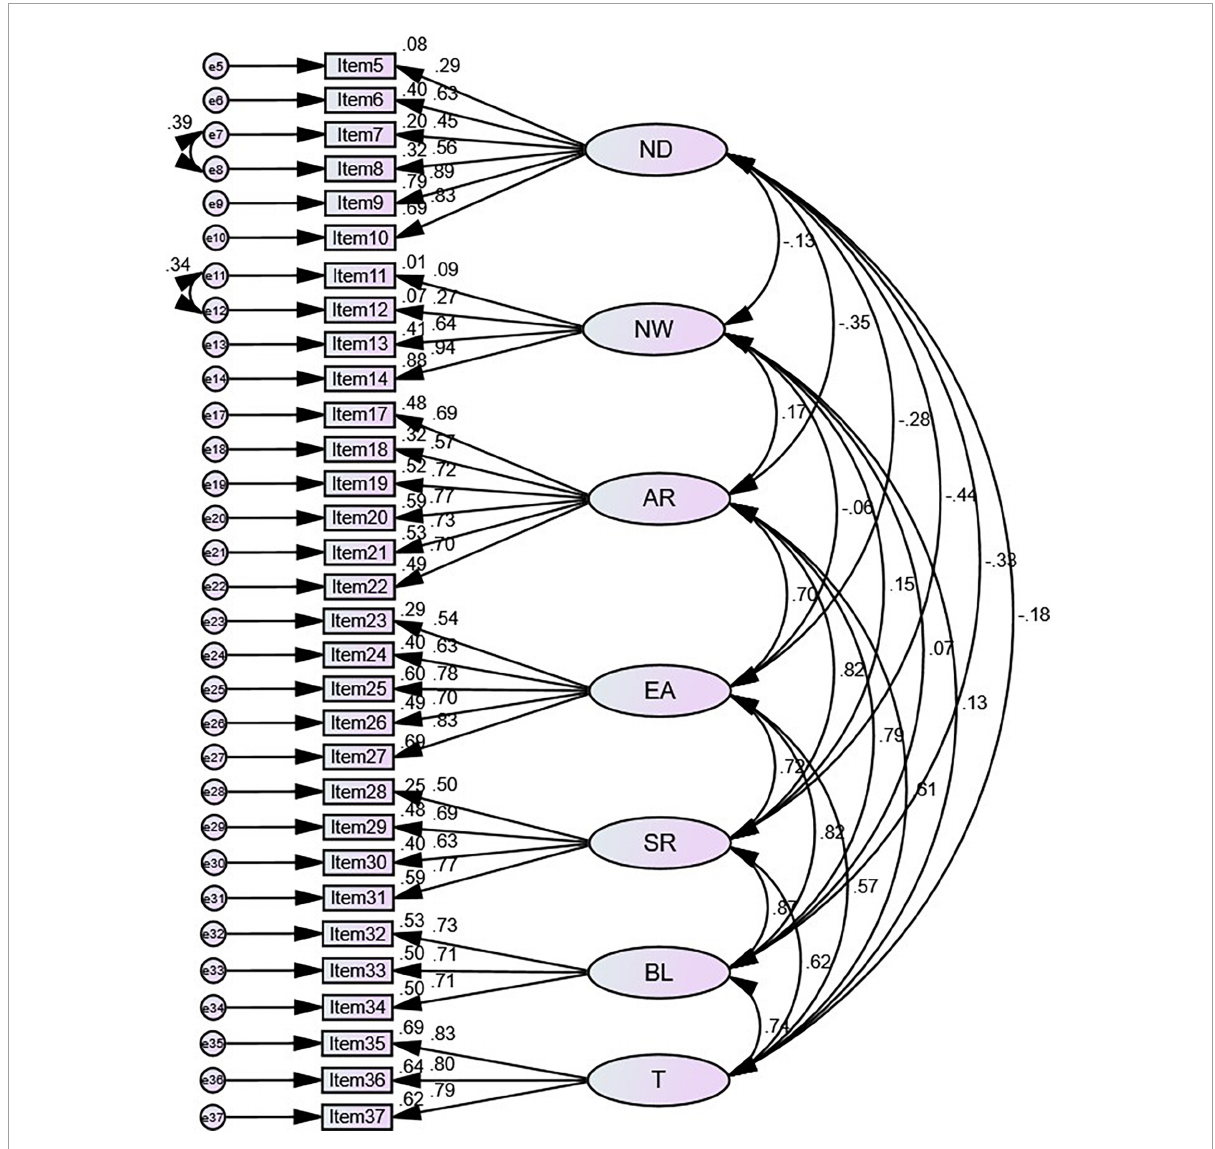
FIGURE1 Structural model of adaptation to the multidimensional assessment of interoceptive awareness Chinese version (MAIA-2C). N, Noticing; ND, Not-Distracting; NW, Not-Worrying; A, Attention Regulation; E, Emotional Awareness; S, Self-Regulation; B, Body Listening; T,